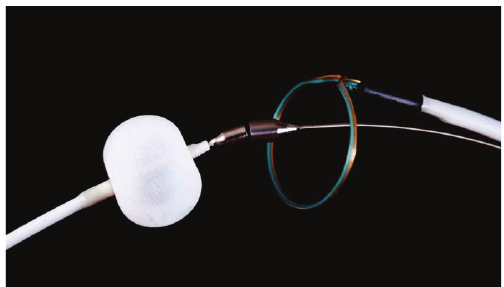
Figure 6: Major components of the LARIAT Suture Delivery Sys- tem, including magnet-tipped guidewires, endovascular balloon catheter, and epicardial snare mounted with a pretied suture loop. ( Image courtesy of SentreHeart, Inc.